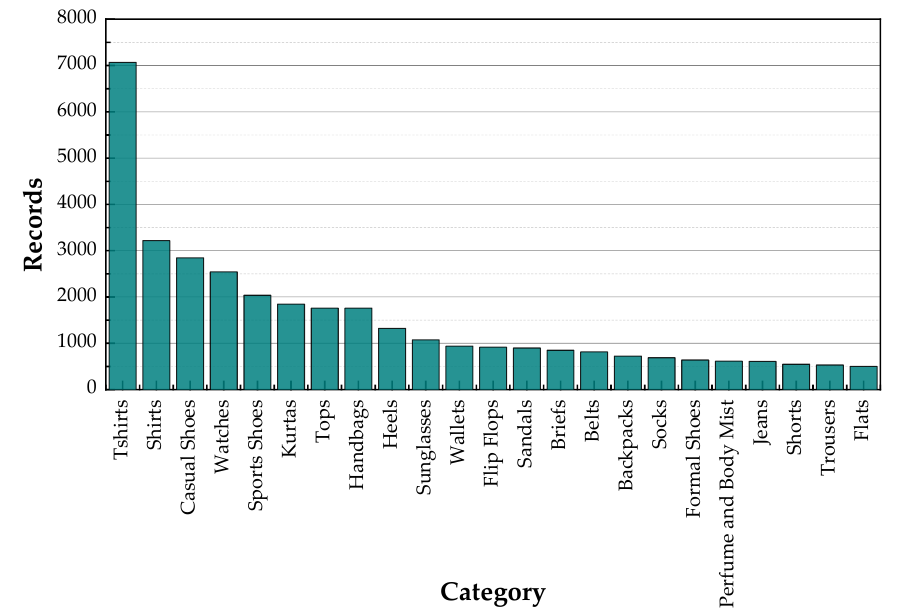
Figure 2. Distribution of the number of records for each article type/category (Fashion Product Images Dataset).